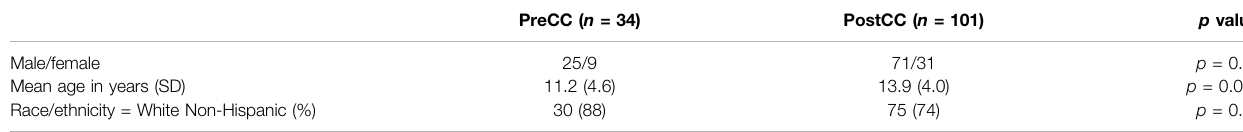
TABLE 1 | Demographics of study population.